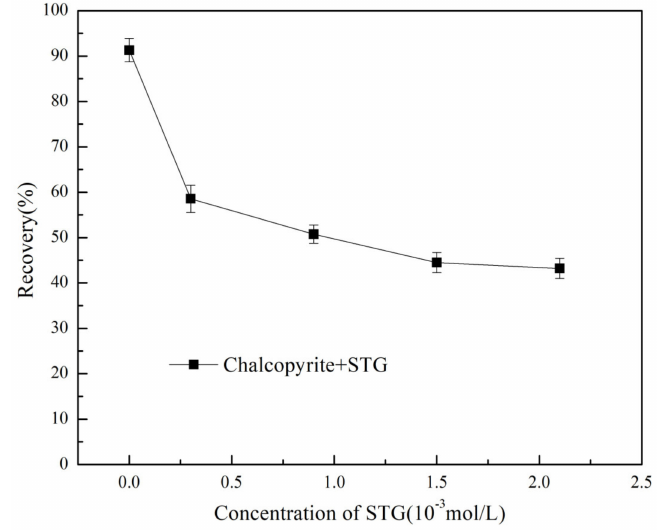
Figure 2. The flotation recovery of chalcopyrite under di ff erent sodium thioglycolate (STG) concentrations; c(BX) = 1 × 10 − 3 mol / L, pH =